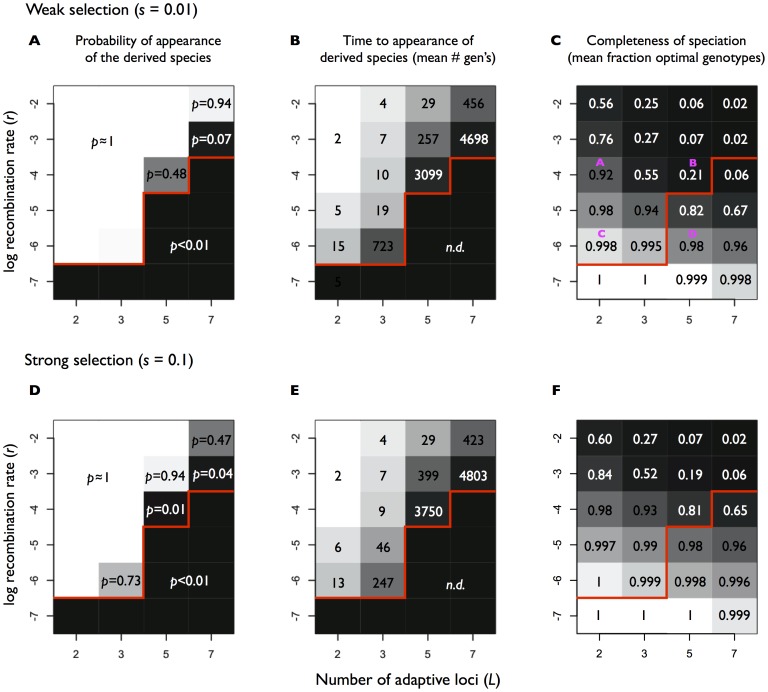
Results of symsim model under additive fitness.(A, B, C) Weak selection. (D, E, F) Strong selection. (A, D) Probability of appearance (p) of the derived (niche 1) optimal genotype in 100 replicate simulations for each combination of the number of loci involved in niche adaptation, L and the recombination rate, r. High probabilities (p = 1) are shown in white, low probabilities in black, and intermediate probabilities in grey scale. The space under the red line indicates extinction of the niche-1 optimal genotype in all 100 replicates (p<0.01). (B, E) Time to appearance of the niche 1 optimal genotype (mean over 100 replicate simulations). The red line is the same as in (A); n.d. refers to appearance time not determined, or effectively infinite, because extinction of niche-1 alleles occurred before the optimal genotype could appear. Shorter times are shown in white, effectively infinite times in black, and intermediate times in grey scale. (C, F) Completeness of speciation. The mean fraction of the pooled populations (niche 0 and 1) occupied by optimally-adapted genotypes is based on 10 replicate simulations for every combination of L and r. Complete speciation (optimal genotype fraction near 1) shown in white, incomplete in black, and intermediate completeness in grey scale. Magenta letters in C refer to the same simulations depicted in panels (A, B, C, D) of Figure 4.